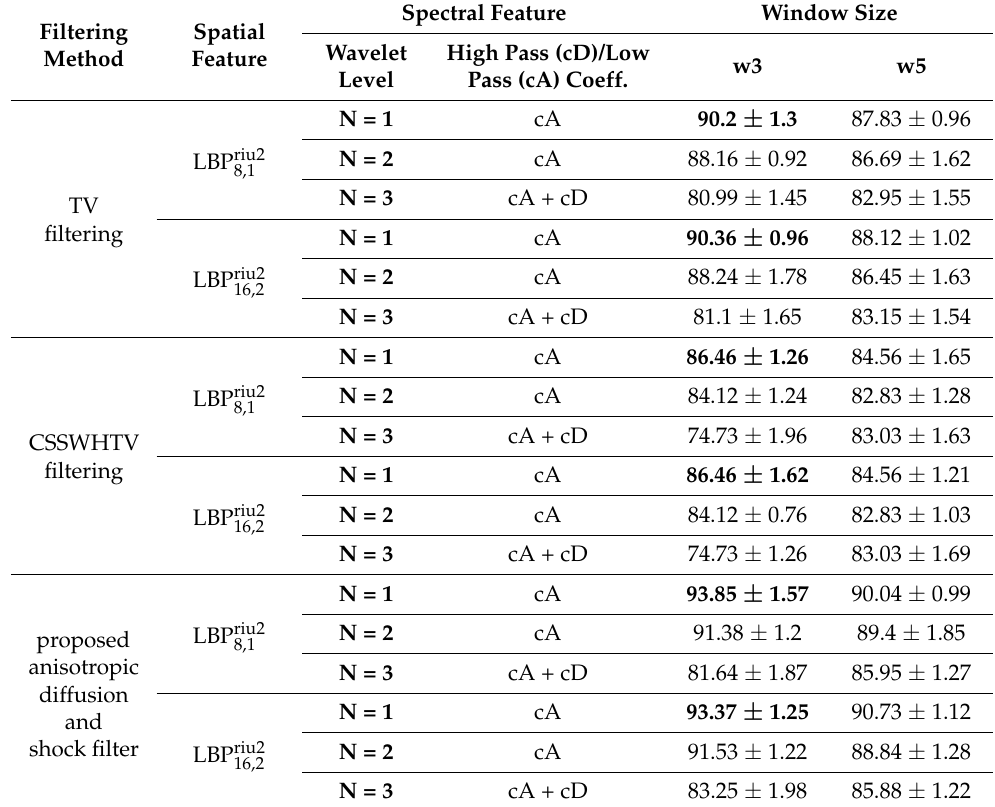
Table 5. Classification accuracy for the Indian Pines dataset, using the TV, the CSSWHTV and the anisotropic diffusion and shock filter-based approaches, with wavelet transform for three levels, with the corresponding window size, of dimension 3 × 3 and 5 × 5, for the controlled sampling strategy and LBP histogram computation, w3 and w5